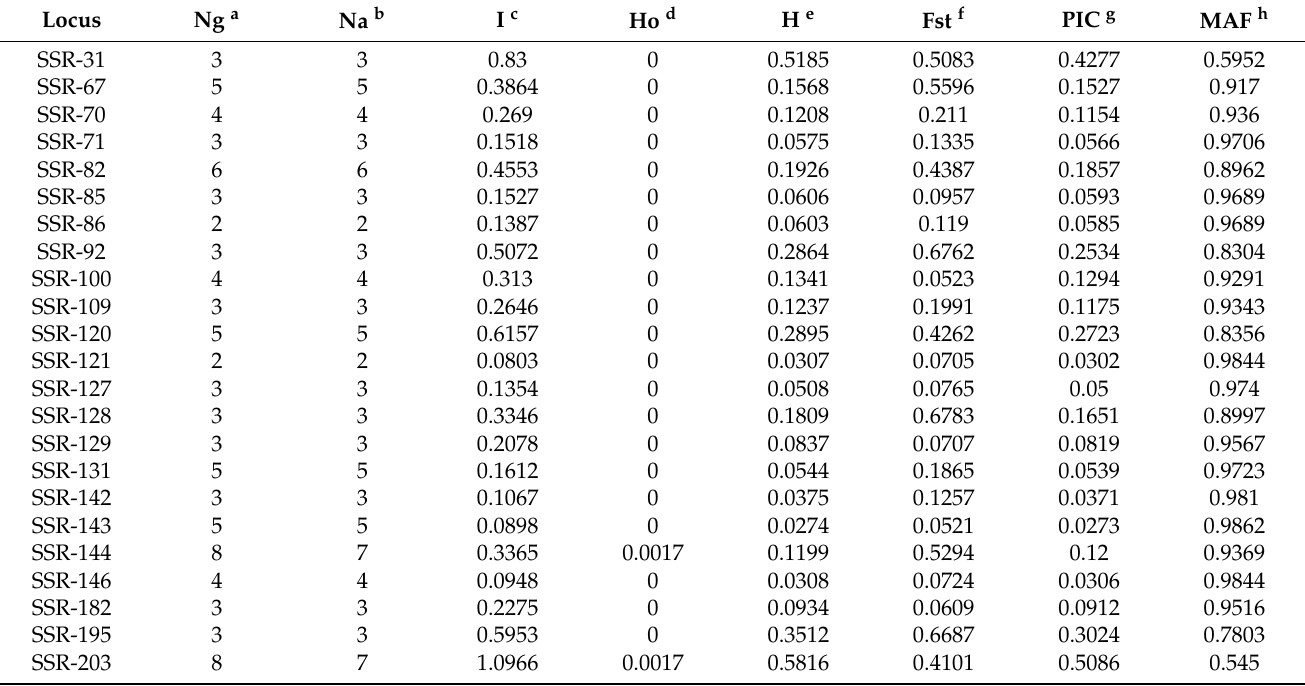
Table 1. Diversity information provided by 37 single-sequence repeat (SSR)